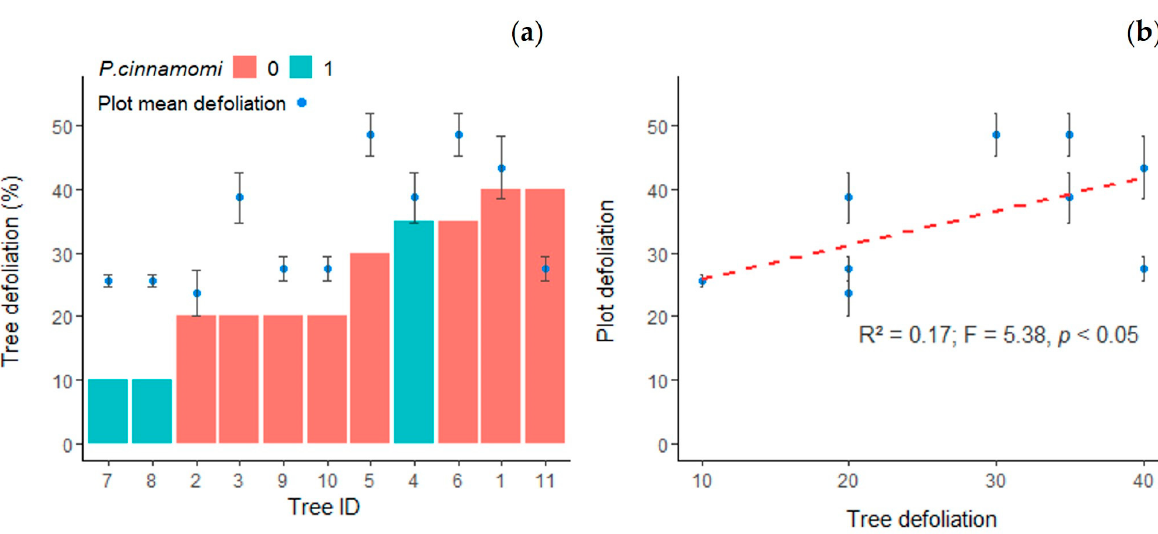
Figure 1. Analysis of tree defoliation status: ( a ) Defoliation of selected trees (bar chart) and average defoliation of the plots in 2019 (blue points). Trees are sorted from low to high defoliation. Colors correspond to positive (1) or negative (0) isolation of P. cinnamomi in the rhizosphere of the tree. Error bars represent the SE of the average plot defoliation. ( b ) Scatterplot of defoliation of selected trees vs. average plot defoliation, including linear regression representation and statistics of the regression model. Error bars represent the SE of the average plot defoliation. Table 2. Comparison between previous metabarcoding results [33] and classic isolation from soil samples. OTU: operational taxonomic unit resulting from the consensus sequence clustering of the metabarcoding analysis of soil DNA for fungal and oomycete communities. Numbers represent the frequency of the OTUs appearing in the rarefied abundance matrix. The symbol # indicates that frequencies refer to a single OTU (OTU#51: Trichoderma sp., OTU#4: P. cinnamomi ). Trichoderma spp .